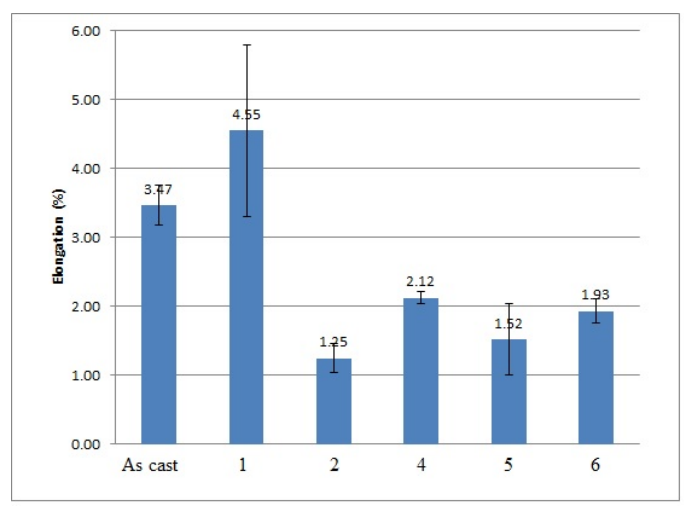
Figure 5. Results of elongation measurements performed on 356 Al alloy: 1—after vibration by 100 Hz; 2—after vibration by 150 Hz; 4—after modification by ultrafine powder modifier; 5—after modification by ultrafine powder modifier followed by 100 Hz vibration; 6—after modification by ultrafine powder modifier followed by 150 Hz vibration; As cast—unmodified and untreated alloy.